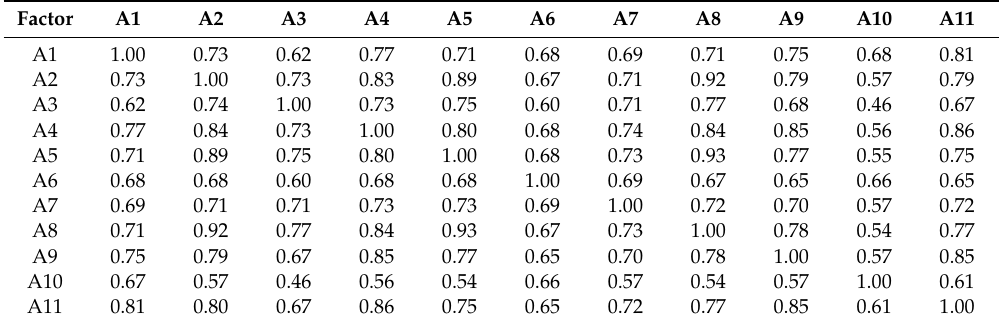
Table 2. Grey relational degree of each